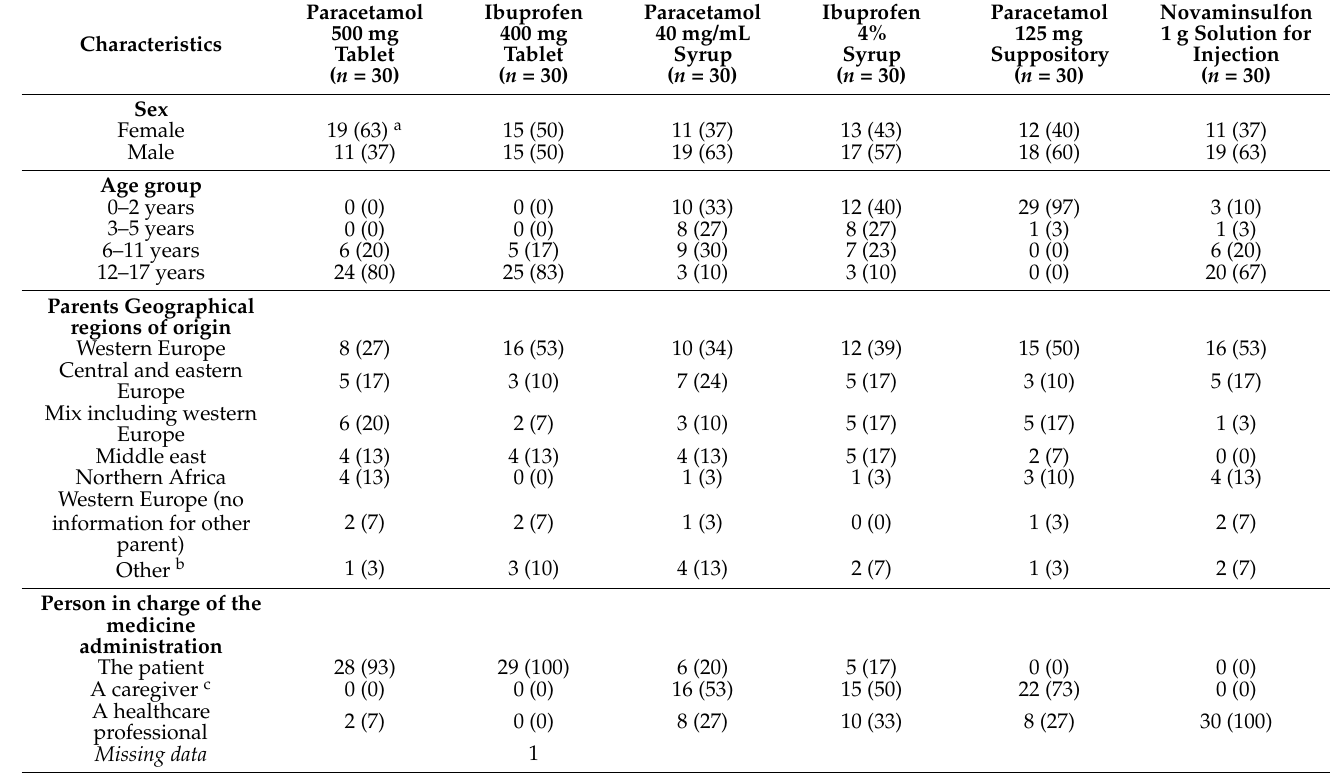
Table 1. Characteristics of the 180 patients included in the study, stratified by medicinal